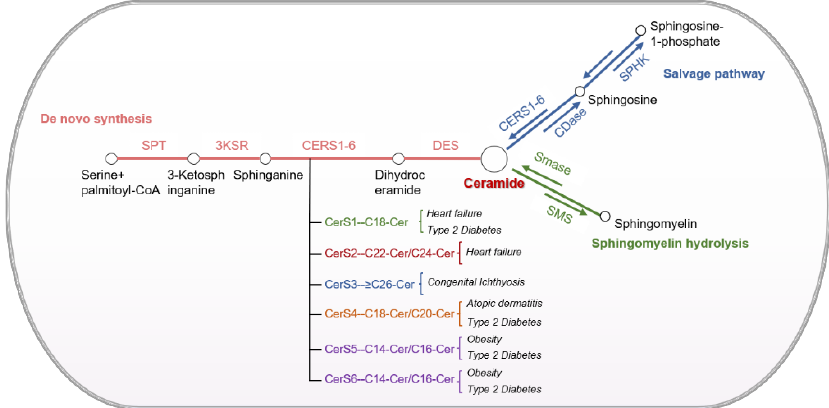
Figure 1. Major ceramide synthesis and metabolic pathways in cardiovascular system: De novo synthesis pathway, sphingomyelin hydrolysis pathway, and the salvage pathway. The rate-limiting enzyme serine palmitoyltransferase (SPT) condenses palmitoyl coenzyme A and serine to form 3-ketosphinganine, then is rapidly reduced to sphingosine by 3-ketosphinganine reductase (3KSR). Sphingosine is acetylated by ceramide synthase (CERS) to yield dihydroceramide, which is further modified by dihydroceramide desaturase (DES) to produce ceramide. Each CerS uses a relatively limited subsection of fatty acyl-CoAs to acylate sphingoid [22,23]; CerS1 utilizes mainly C18-CoA and is mainly associated with heart failure and type 2 diabetes, while CerS2 has acyl-CoA specificity and utilizes longer acyl-CoA chains (C20-C26) for ceramide synthesis, which is closely associated mainly with heart failure [24–26]. CerS3 uses very long acyl-CoA (greater than C26), which affects congenital ichthyosis onset and progression, while CerS4 uses C18- and C20-CoA closely associated with the diseases atopic dermatitis and type 2 diabetes [27–29]. In addition, CerS5 and CerS6 are more likely to produce short-chain ceramides, such as C14- and C16-CoA, mainly in obesity and type 2 diabetes [30–33]. Sphingomyelinase (SMase) hydrolyses sphingomyelin (SM) to ceramide, and SM synthase converts ceramide to SM. Ceramides can also be transformed into sphingosine by the action of ceramidase, and are subsequently phosphorylated by sphingosine kinase (Sphk) to produce the bioactive lipid sphingosine 1-phosphate (S1P). SPT, serine palmitoyltransferase; 3KSR, 3-ketosphinganine reductase; CERS, ceramide synthase; DES, dihydroceramide desaturase ; SMase, sphingomyelinase; SMS, sphingomyelin synthase; CDase, ceramidase; Sphk, sphingosine kinase; S1P, sphingosine 1-phosphate.